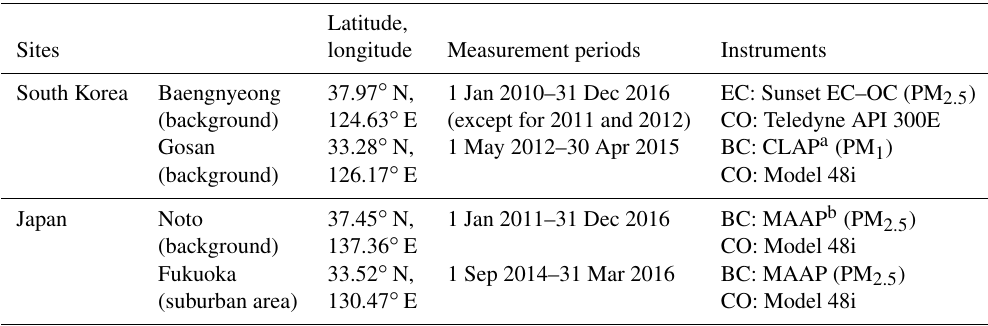
Table 1. Description of the measurement sites, periods, and